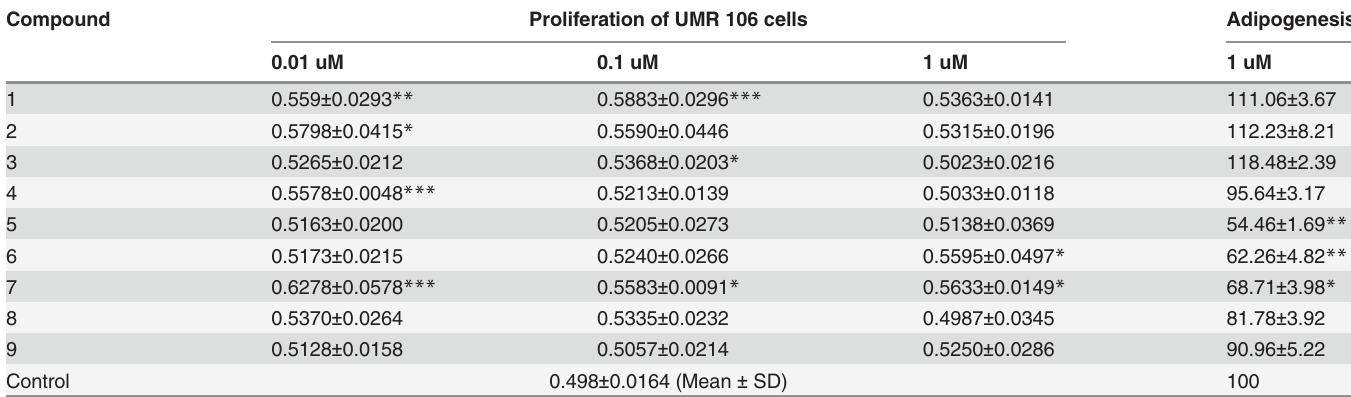
Table 6. Effect of the nine compounds on the proliferation of UMR 106 cells and adipogenesis in 3T3-L1 cells.